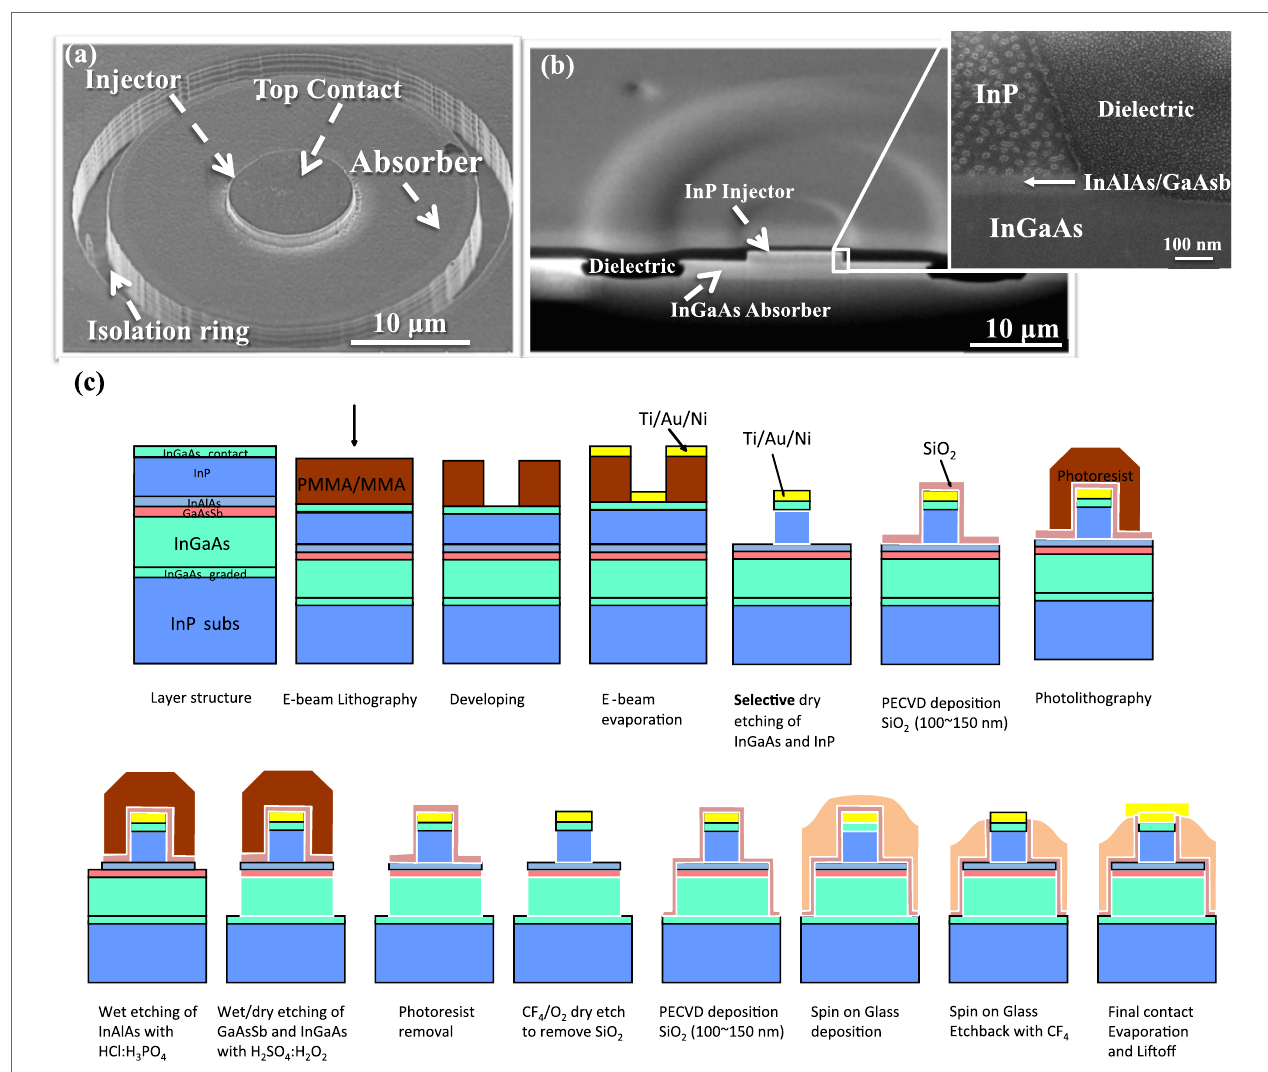
FiGURe 4 | (A) SEM image of a second-generation electron-injection detector with 30 μ m diameter absorber and 10 μ m diameter injector. (B) A cross sectional SEM of the device through its center. Detector is planarized by a dielectric material (Silicon on Glass). Inset shows a zoomed SEM of InP injector, GaAsSb trapping layer/InAlAs etch stop and part of InGaAs absorber. (C) Schematic diagram of process flow. Reproduced with permission from Fathipour et al. (2015). Copyright 2015 AIP Publishing